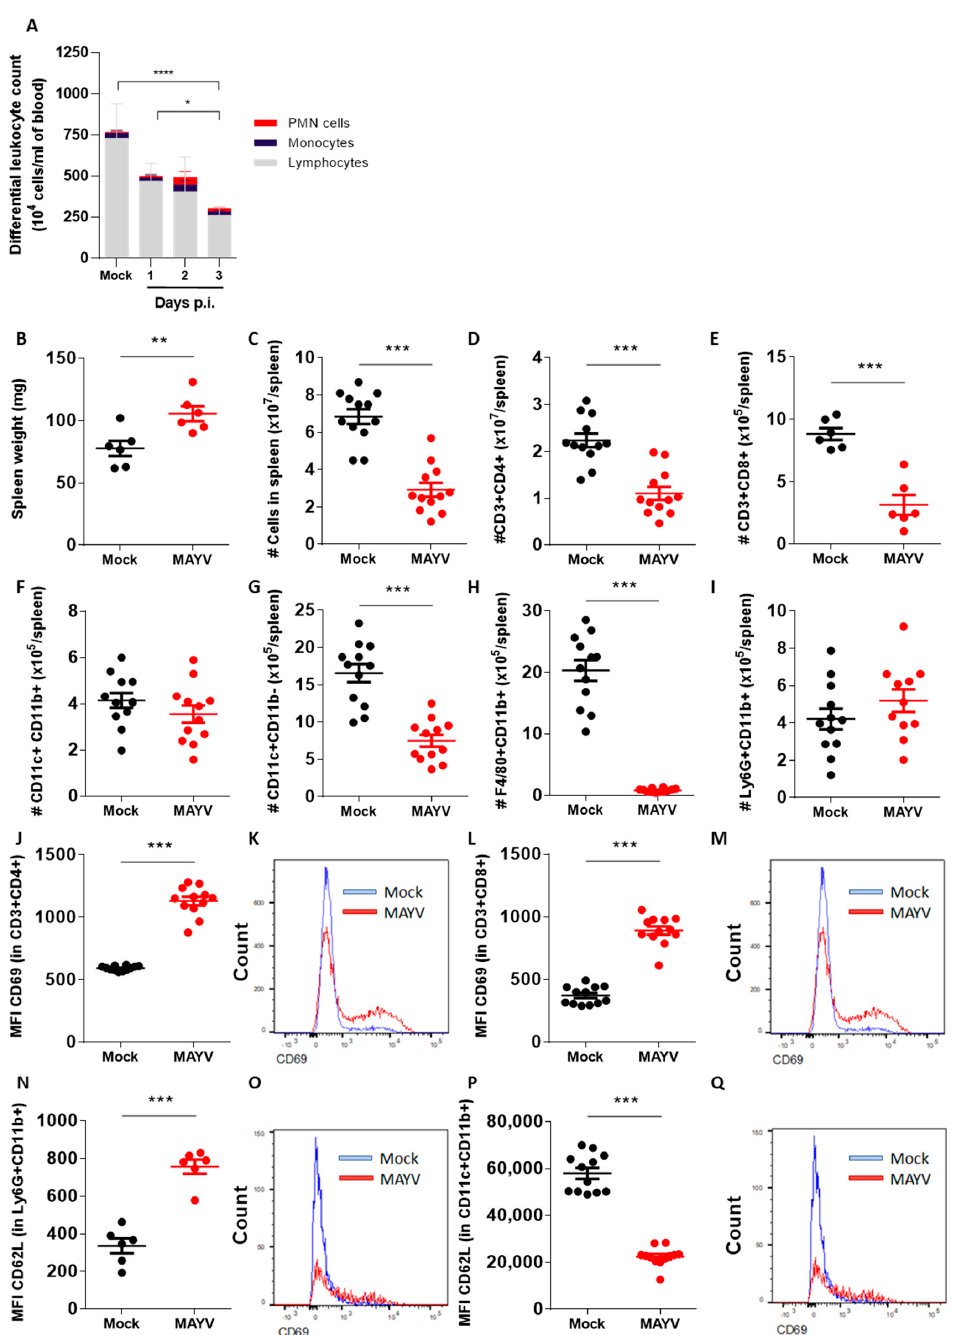
Figure 2. Inoculation of MAYV in immunodeficient IFNAR − / − mice results in lymphopenia and in significant reduction of leukocyte populations in the spleen. ( A ) Differential leukocyte counts from peripheral blood of IFNAR − / − mice infected with 10 2 PFU MAYV via intraplantar injection at days 1 to 3 p.i. ( B ) Spleen weight of mock- and MAYV-infected mice on day 3 p.i. ( C – Q ) Flow cytometry results from spleens of mock- and MAYV-infected mice on day 3 p.i. Absolute numbers of ( C ) total splenic cells, ( D ) T CD4+ and ( E ) T CD8+ lymphocytes, ( F , G ) populations of CD11b+ and CD11b- dendritic cells, ( H ) macrophages and ( I ) neutrophils. ( J ) Medium fluorescence intensity (MFI) and ( K ) histogram of CD69 in T CD4+ lymphocytes. ( L ) MFI and ( M ) histogram of CD69 in T CD8+ lymphocytes. ( N ) MFI and ( O ) histogram of CD62L in neutrophils. ( P ) MFI and ( Q ) histogram of MHC-II in macrophages. Data presented as mean ± SEM. * p < 0.05, ** p < 0.01, *** p < 0.001, **** p < 0.0001. See also Supplementary Figure